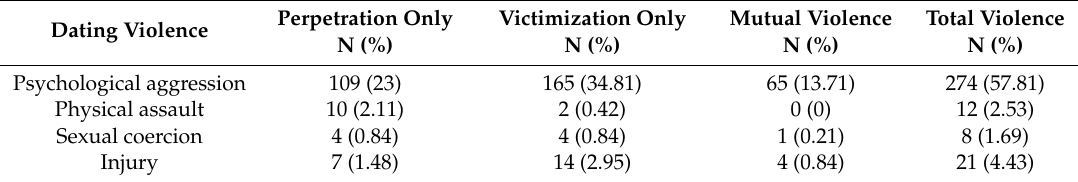
Table 1. Percentage of participants who reported dating violence.